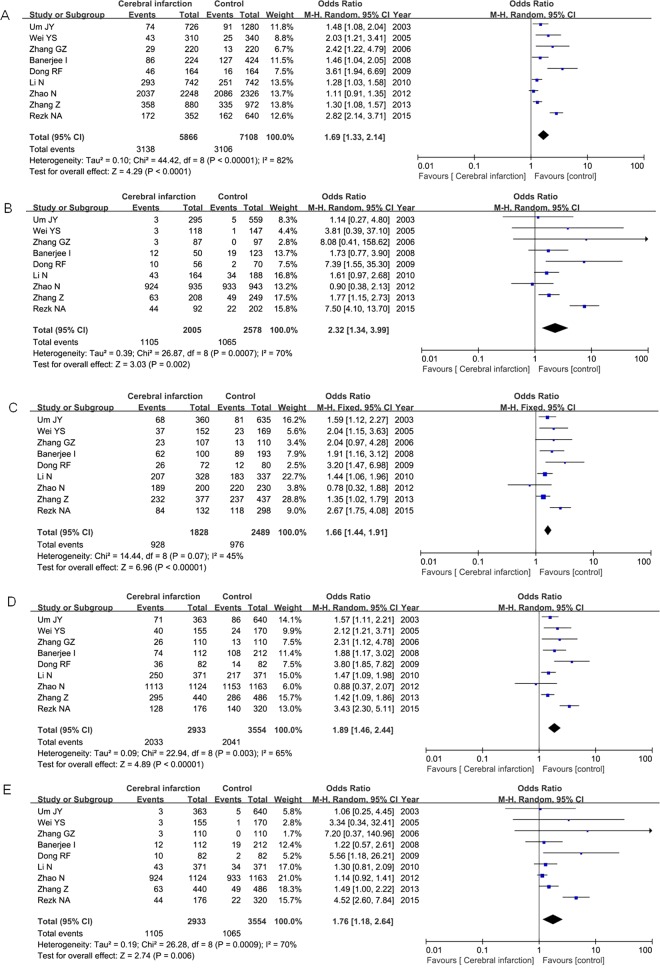
Meta-analysis of the relationship between the IL-1α −899C/T polymorphism and cerebral infarction risk under the allelic model (A), homologous model (B), heterogeneous model (C), dominant model (D) and recessive model (E).